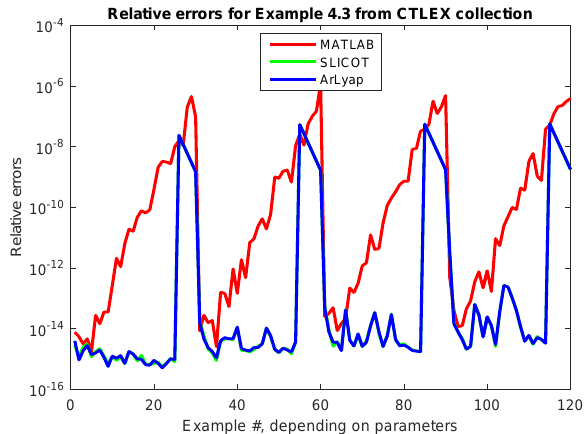
Figure 6. Relative errors for CTLEX 4.3 series of examples.